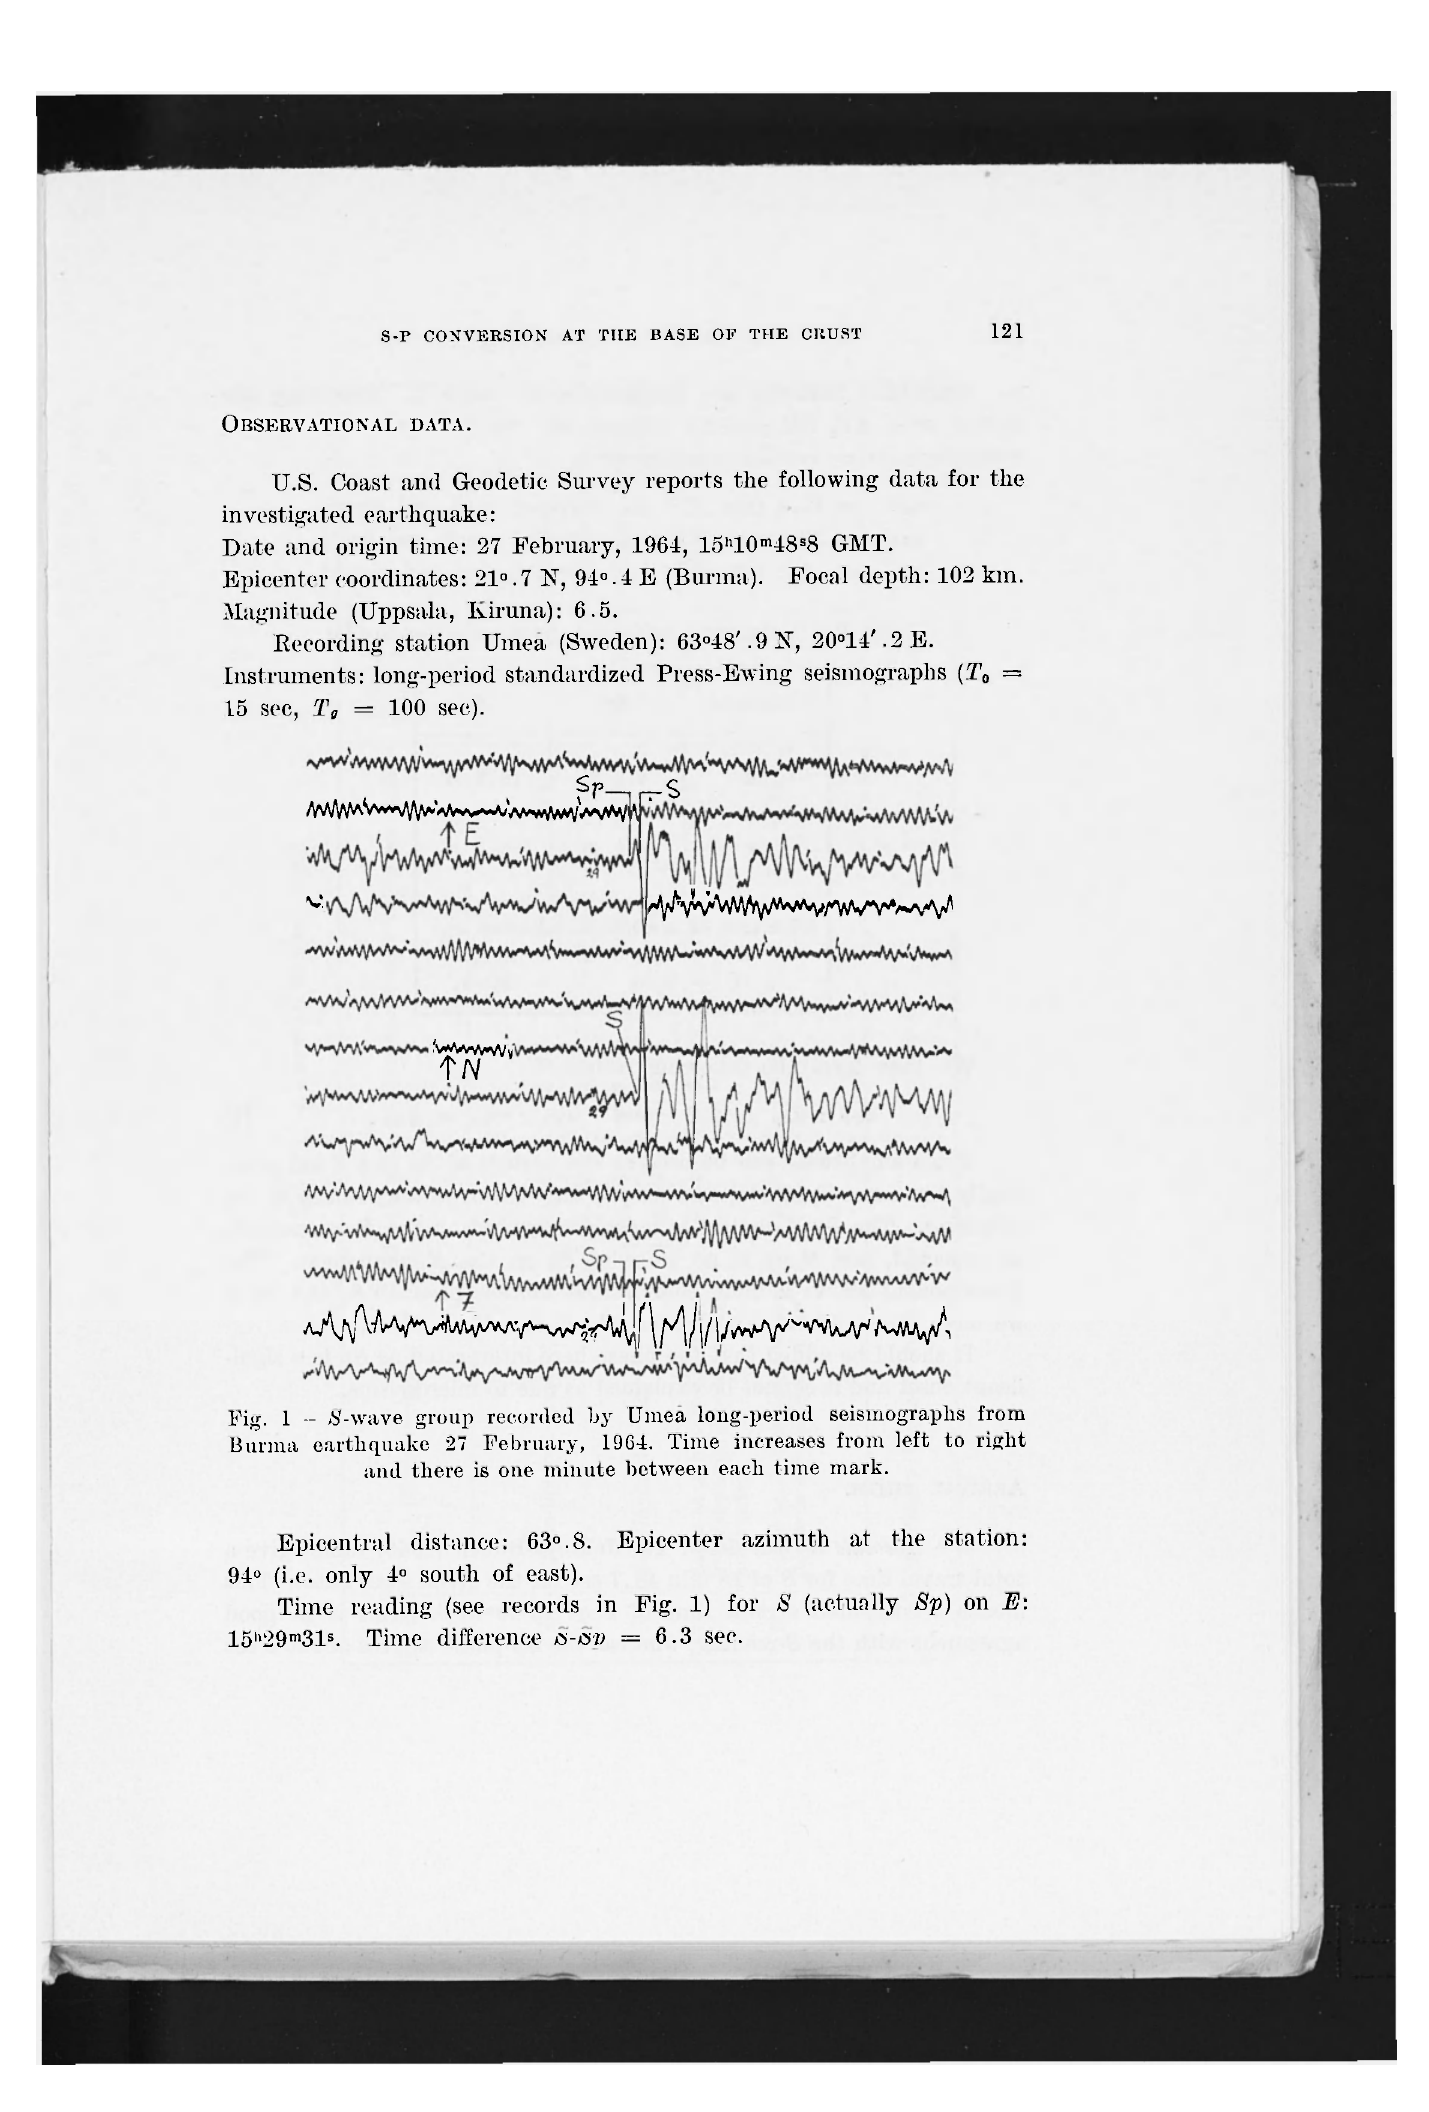
Fig. 1 - S-wave group recorded by Umea long-period seismographs Burma earthquake 27 February, 1964. Time increases from left to and there is one minute between each time mark. Epicentral distance: 63°.8. Epicenter azimuth at the station: 94° (i.e. only 4° south of